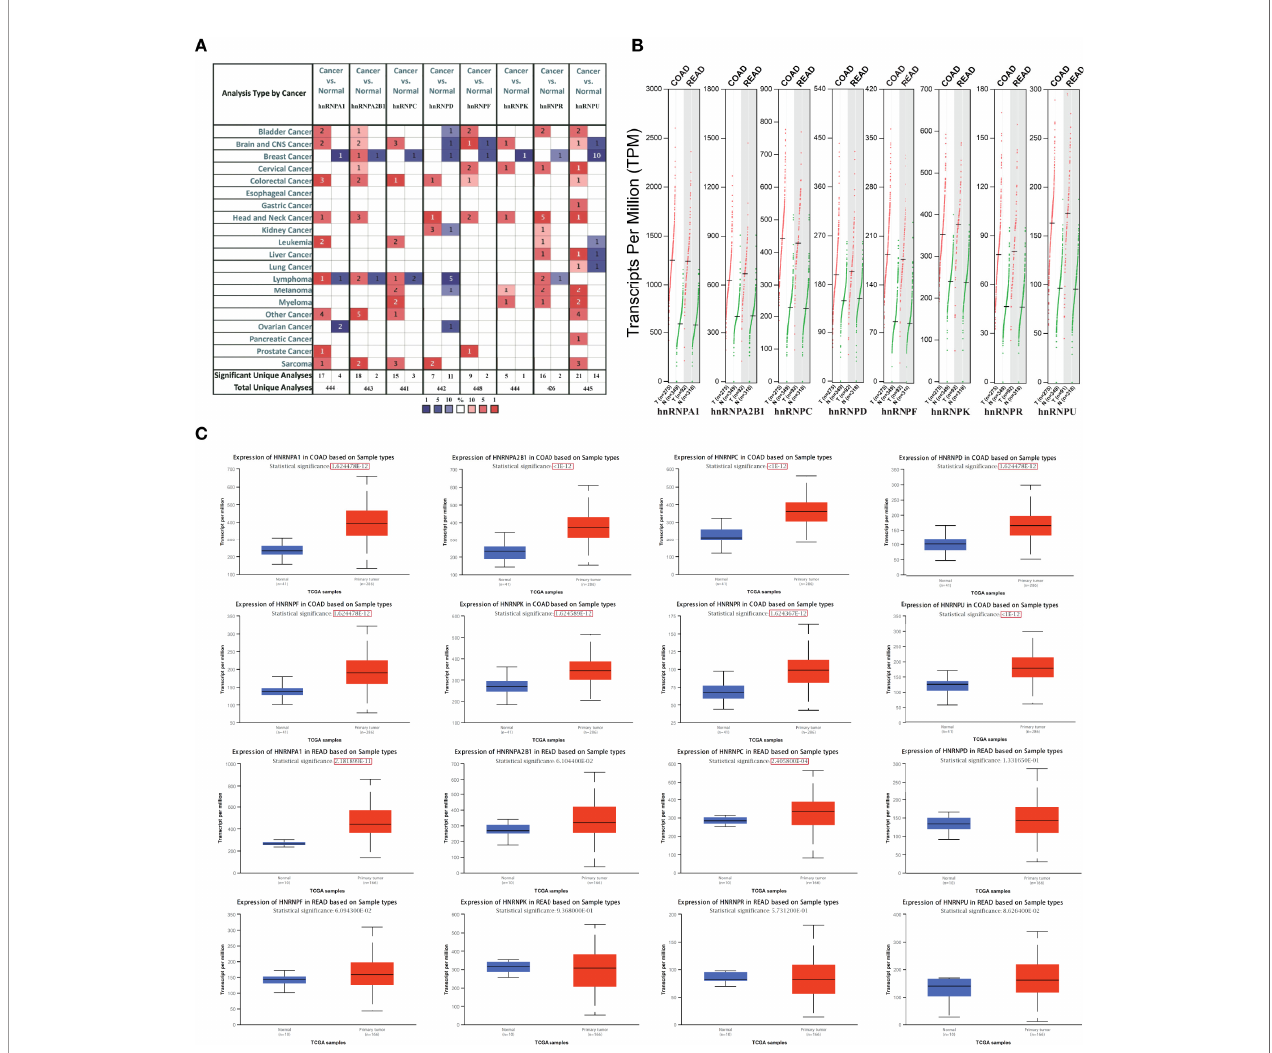
FIGURE 1 | The expression levels of hnRNPs were upregulated in colorectal adenocarcinoma tissues. (A) The transcriptional levels of hnRNPs were observed in cancer samples by using ONCOMINE databases. As shown, the expression levels of hnRNPs were upregulated in colorectal cancer tissues compared with the normal tissues. (B) In GEPIA database, the transcripts per million (TPM) levels of hnRNPA1/A2B1/C/D/F/K/R/U were upregulated in COAD and READ tissues. (C) In UALCAN databases, the TPM levels of hnRNPA1/A2B1/C/D/F/K/R/U were upregulated in COAD tissues compared with the normal tissues. In READ tissues, the TPM levels of hnRNPA1/C were statistically upregulated, and hnRNPA2B1/D/F/K/R/U exhibited the upregulated